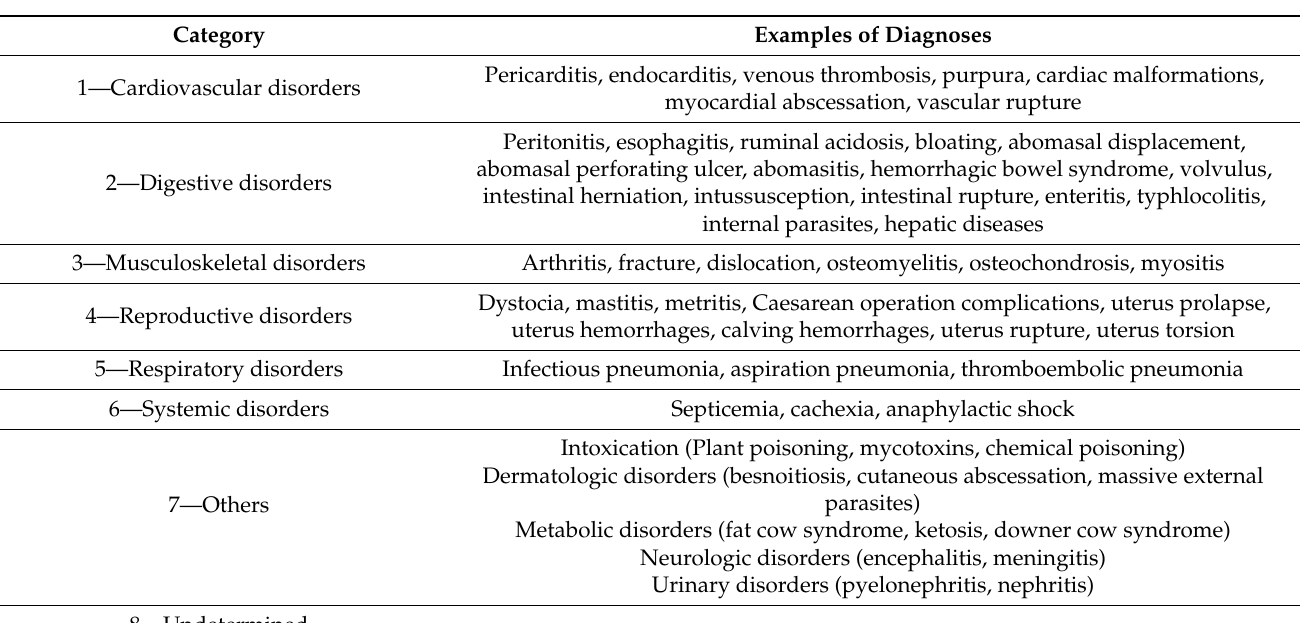
Table 1. List of the 8 categories used to classify the principal cause of death in necropsied adult cattle with illustrating examples.